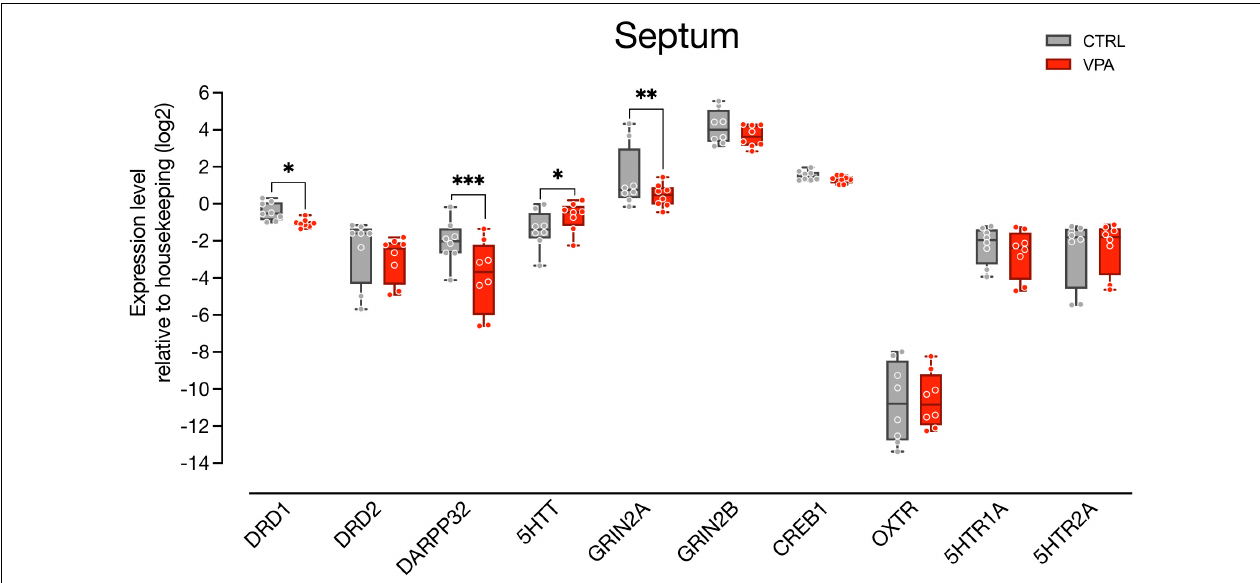
FIGURE 3 | Gene expression levels in the septum. Box and whisker plot (median, min to max) of relative expression (dCt, log2) values for each group. Changes in expression of DRD1, DRD2, DARPP32, 5HTT, GRIN2A, GRIN2B, CREB1, OXTR, 5HTR1A, and 5HTR2A in septum samples collected from P2 chicks embryonically exposed to VPA. ∗ p < 0.05, ∗∗ p < 0.001, ∗∗∗ p <